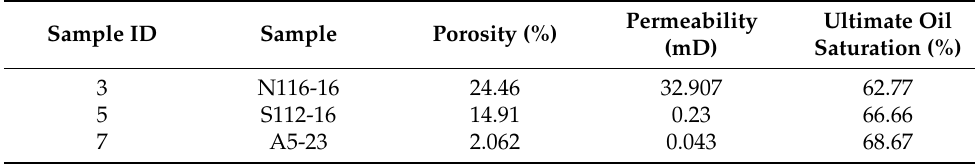
Table 8. Ultimate oil saturation parameters of